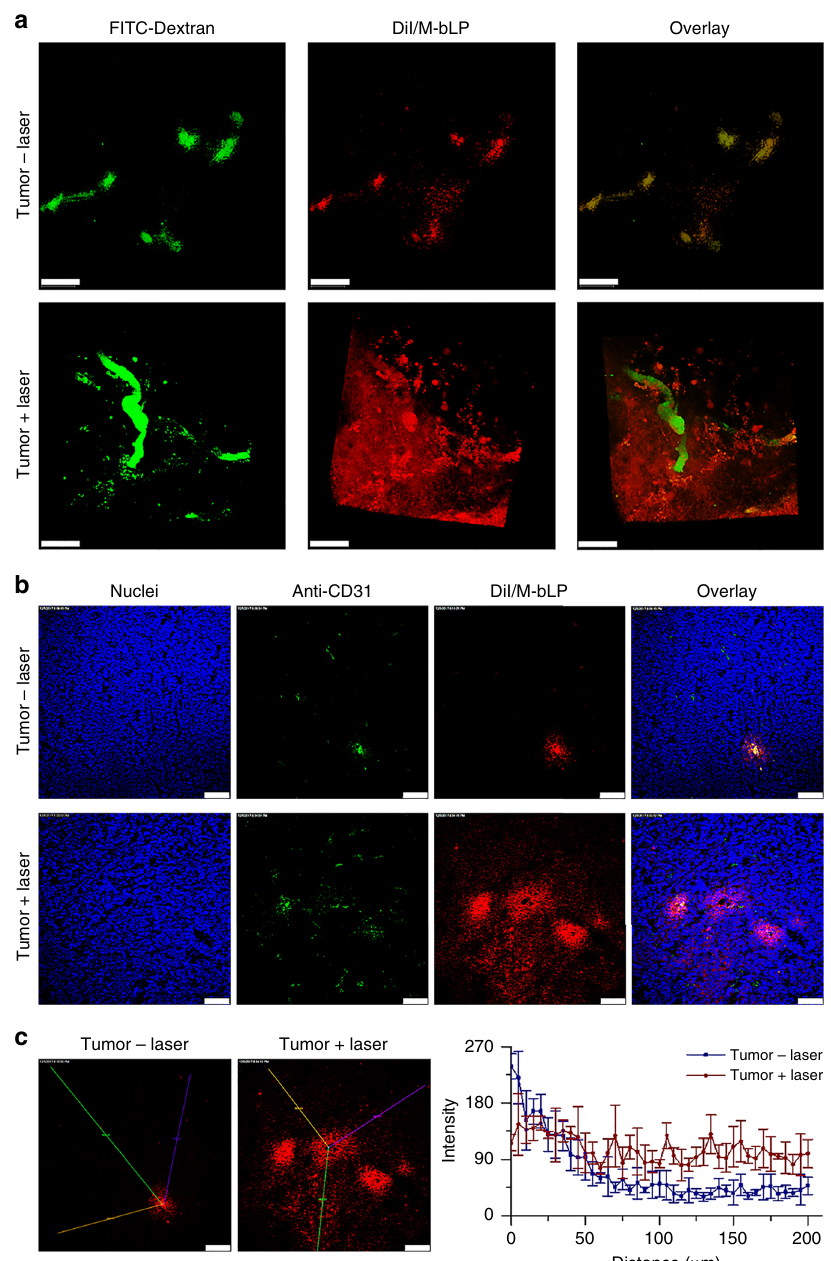
Fig. 6 Impact of D-bLP-mediated TSM remodeling on extravasation of second DiI/M-bLP from tumor vasculatures. a Extravasation of DiI/M-bLP from tumor vessels of untreated and laser-irradiated tumors, scale bar, 100 µ m. b Diffusion of DiI/M-bLP from tumor vessels into the distal matrix in tumor with and without laser irradiation, scale bar, 75 µ m. c Quanti fi ed diffusion of DiI/M-bLP from tumor vessels to the distal matrix by Image J software. The data are means± SD, n =